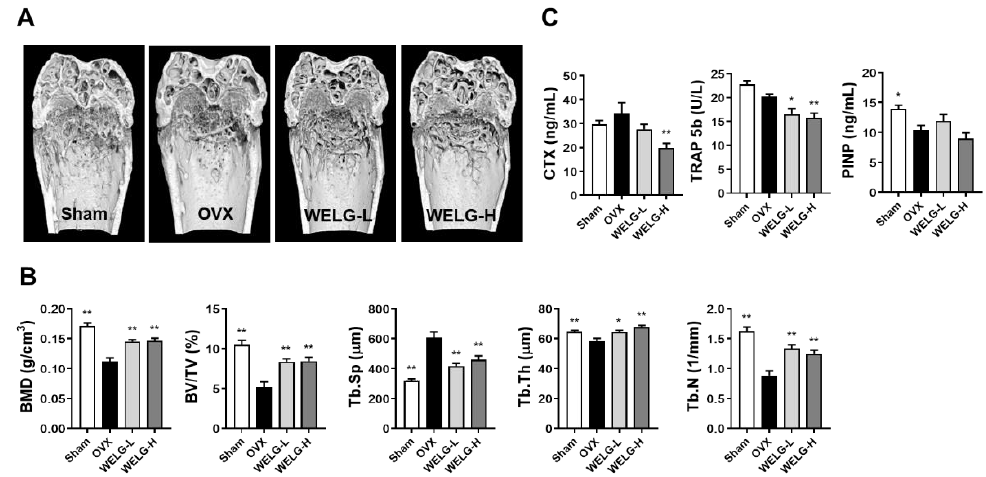
Figure 4. Preventive effects of WELG administration on OVX-induced bone loss in vivo. Mice were orally administered distilled water, WELG-L (100 mg/kg; Low), or WELG-H (300 mg/kg; High) for 6 weeks beginning 1 week after OVX or sham surgery. ( A ) Three-dimensional reconstruction images of the distal femur by micro-computed tomography. ( B ) Morphometric analyses of metaphyseal trabecular bone microstructure. ( C ) Serum levels of CTX, TRAP 5b and PINP. * p < 0.05, ** p < 0.01 versus OVX